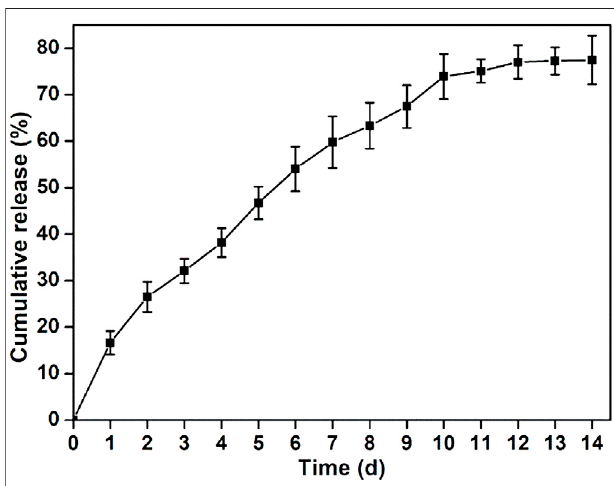
FIGURE 4 | Cytotoxicity of GelMA-CS@KGN hydrogel in vitro . (A) Live/dead staining of BMSCs. Cells in green manifest living ones while cells in red manifest dead ones. (B) Cell viability. (C) Cell proliferation of GelMA-CS@KGN hydrogel after cultivating for various time ( n = 3, ** p < 0.01).